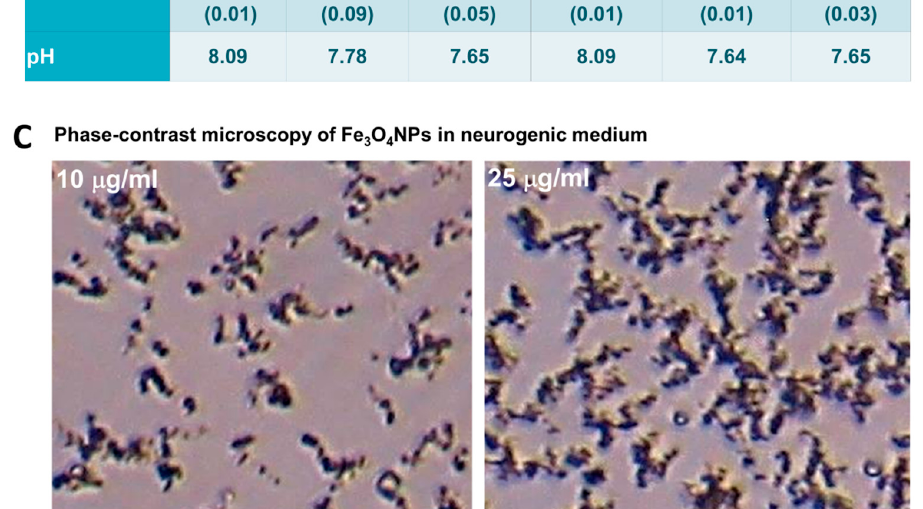
Figure 6. Physico-chemical characteristics of the Fe 3 O 4 NPs in mesenchymal stem cell neurogenic differentiation medium. ( A ) Size distribution obtained from dynamic light scattering measurements of Fe 3 O 4 NPs at concentrations of 10 and 25 μ g/mL in mesenchymal stem cell neurogenic differentiation medium after 30 min, 24 and 48 h. ( B ) Physico-chemical properties of the Fe 3 O 4 NPs in mesenchymal stem cell neurogenic differentiation medium. ( C ) Phase-contrast micrographs of Fe 3 O 4 NPs in neurogenic medium at 10 and 25 μ g/mL after 48 h: aggregations/agglomerations of the Fe 3 O 4 NPs were observed as brownish sediments, which increased as function of the concentration. Scale bar: 20 μ m.